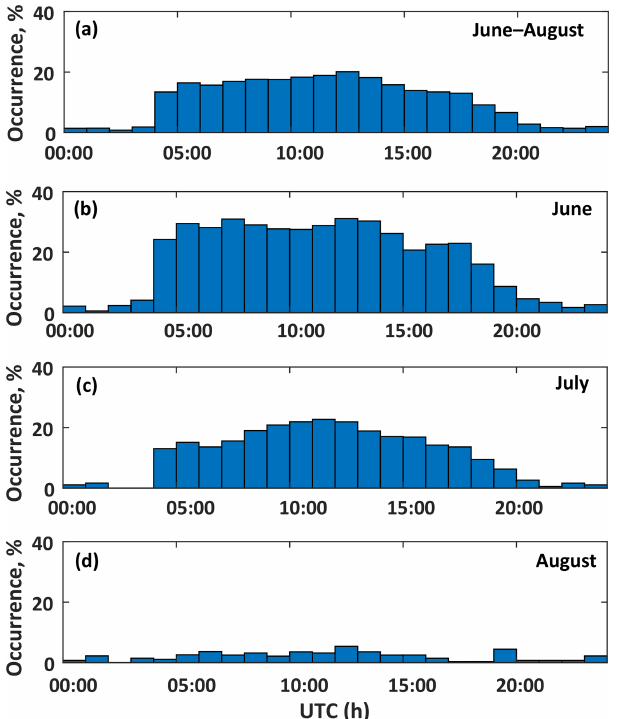
Figure 1. The 24h composites of MSE occurrences (with respect to 00:00UTC time) for all days of summer (a) , and the days of June, July, and August ( b , c , and d , respectively).